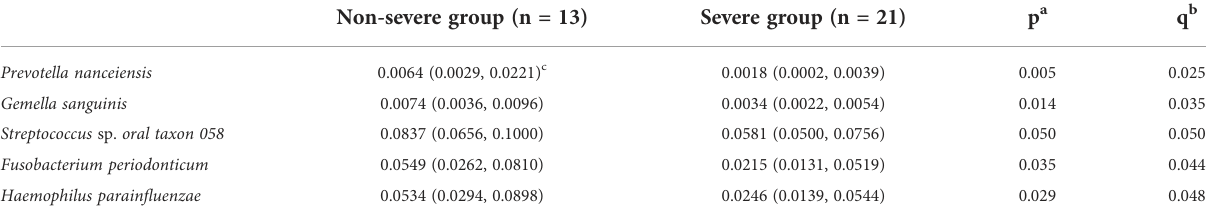
TABLE 2 Comparison of the relative abundance of bacterial species between the non-severe and severe